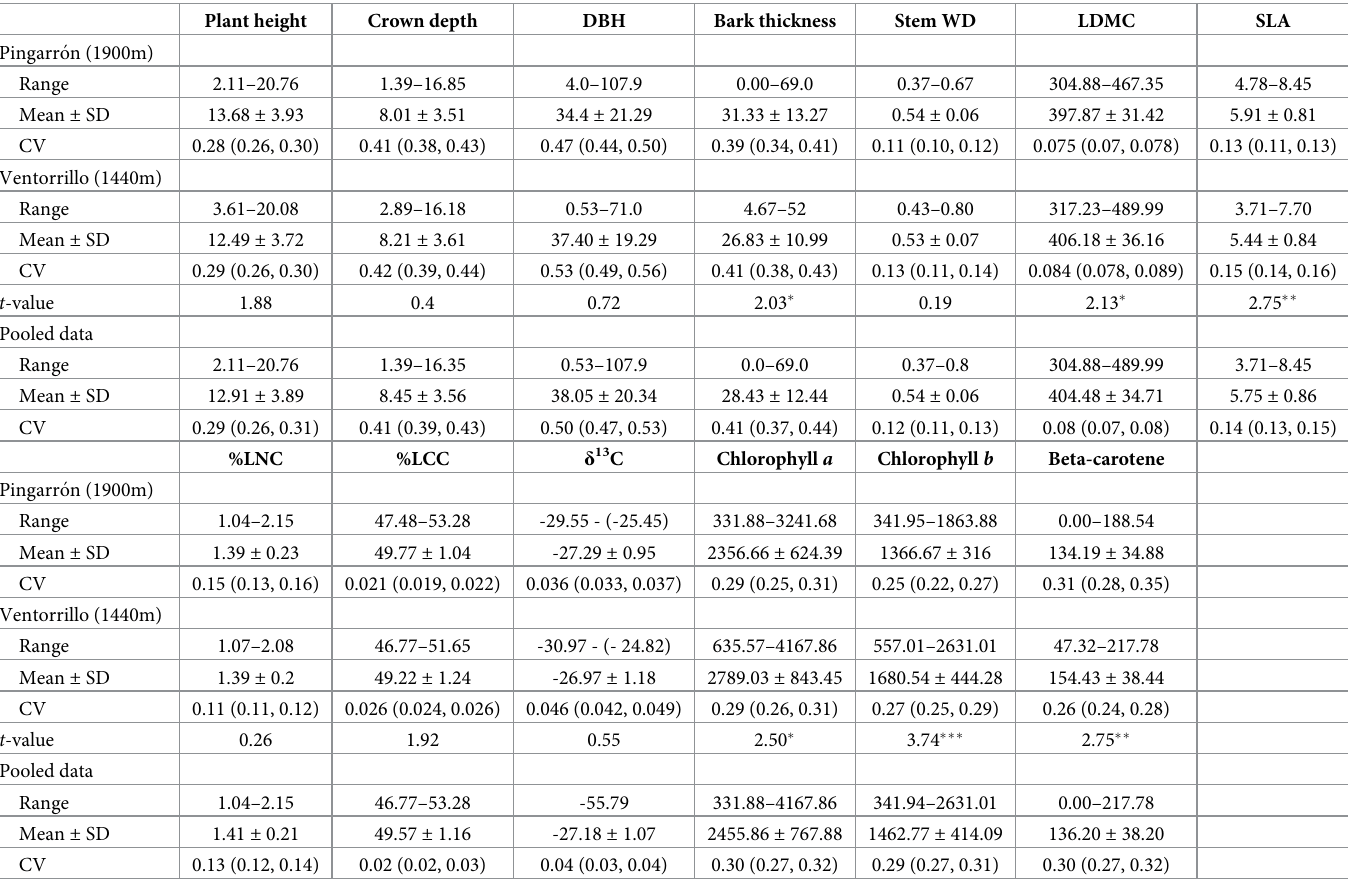
Table 2. Descriptive statistics of the study traits measured on Pinus sylvestris individual